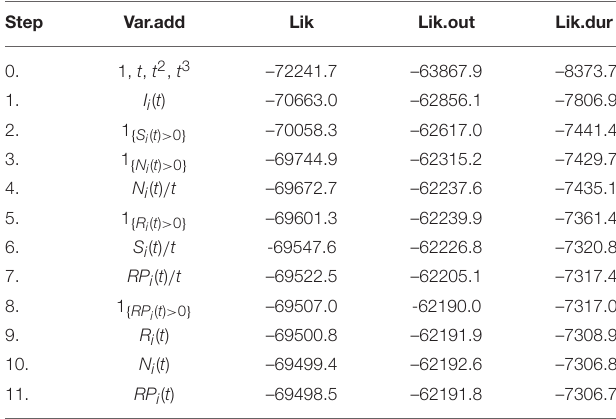
TABLE 3 | Results on model selection based on a stepwise forward selection